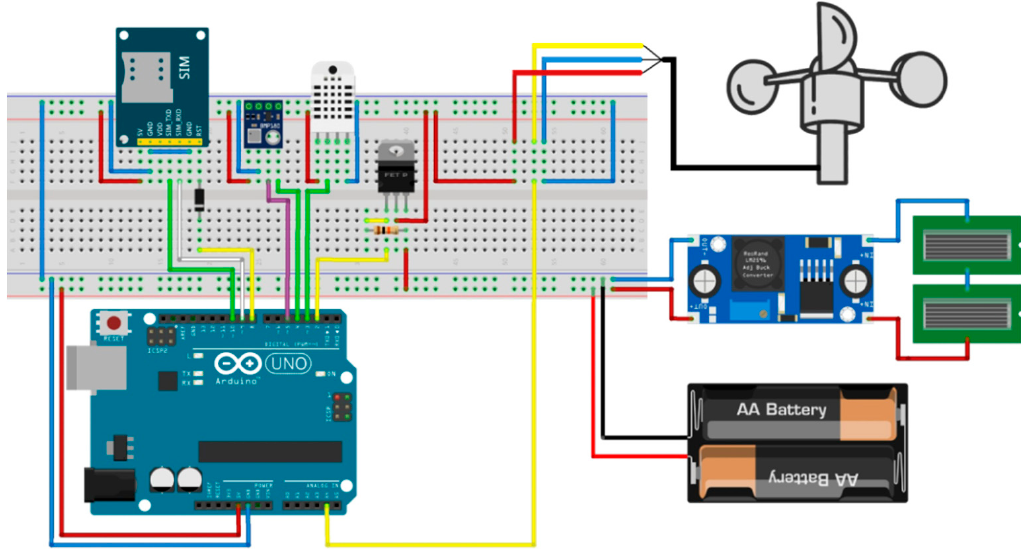
Figure 11. Arduino AMS based on the project described in [37], breadboard scheme.